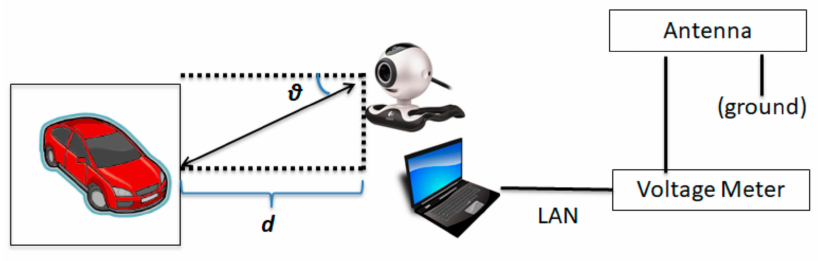
Figure 10. The experimental circumstances in the